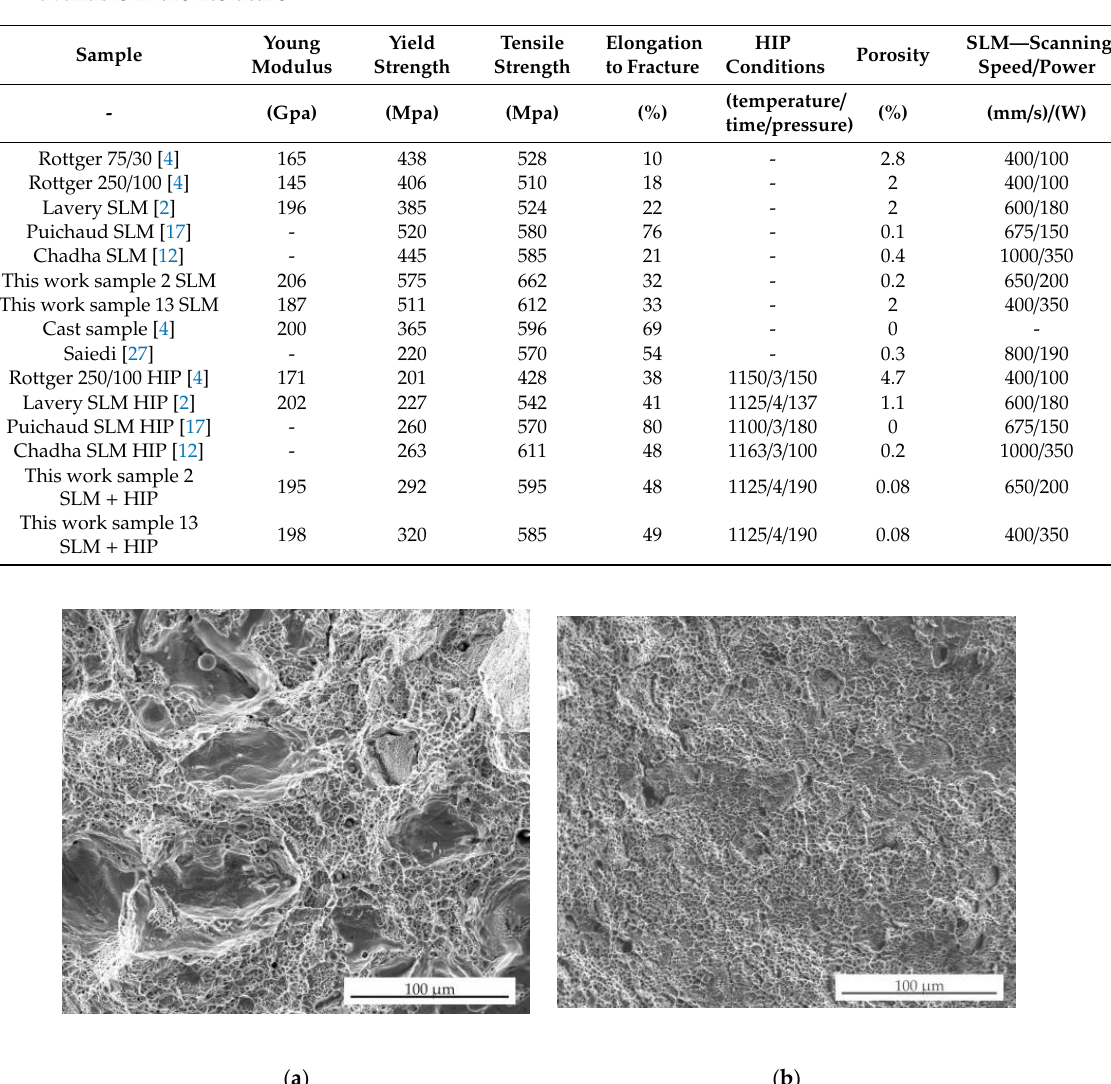
Table 8. Results of tensile experiments and values of mechanical properties of SLM and HIP samples available in the literature.